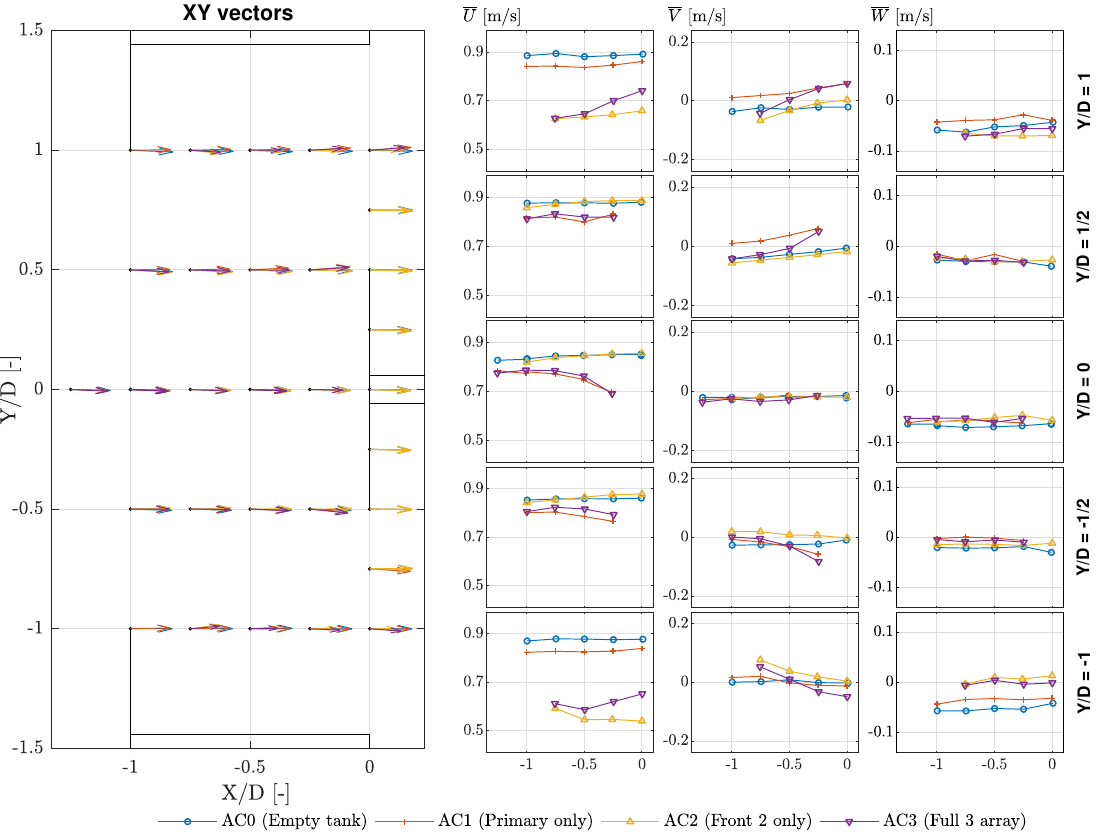
Figure 6. Variation of flow between turbine locations. Subplots show (left) X–Y velocity vectors relative to turbine/blade positions, and (right) U V W at points on five streamwise transects. For details of array layout and configurations tested see Figure